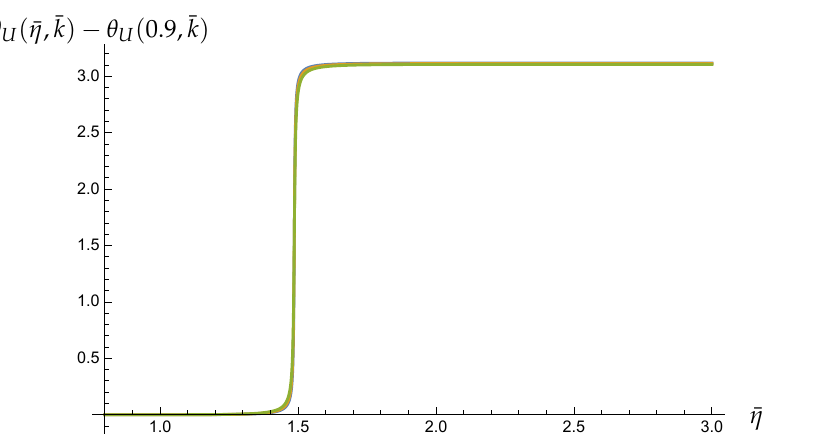
Figure A7. Plots of θ U ( ¯ η , ¯ k ) − θ U ( 0.9, ¯ k ) [rad] with ¯ k = e − 60 (blue), e − 50 (yellow) and e − 40